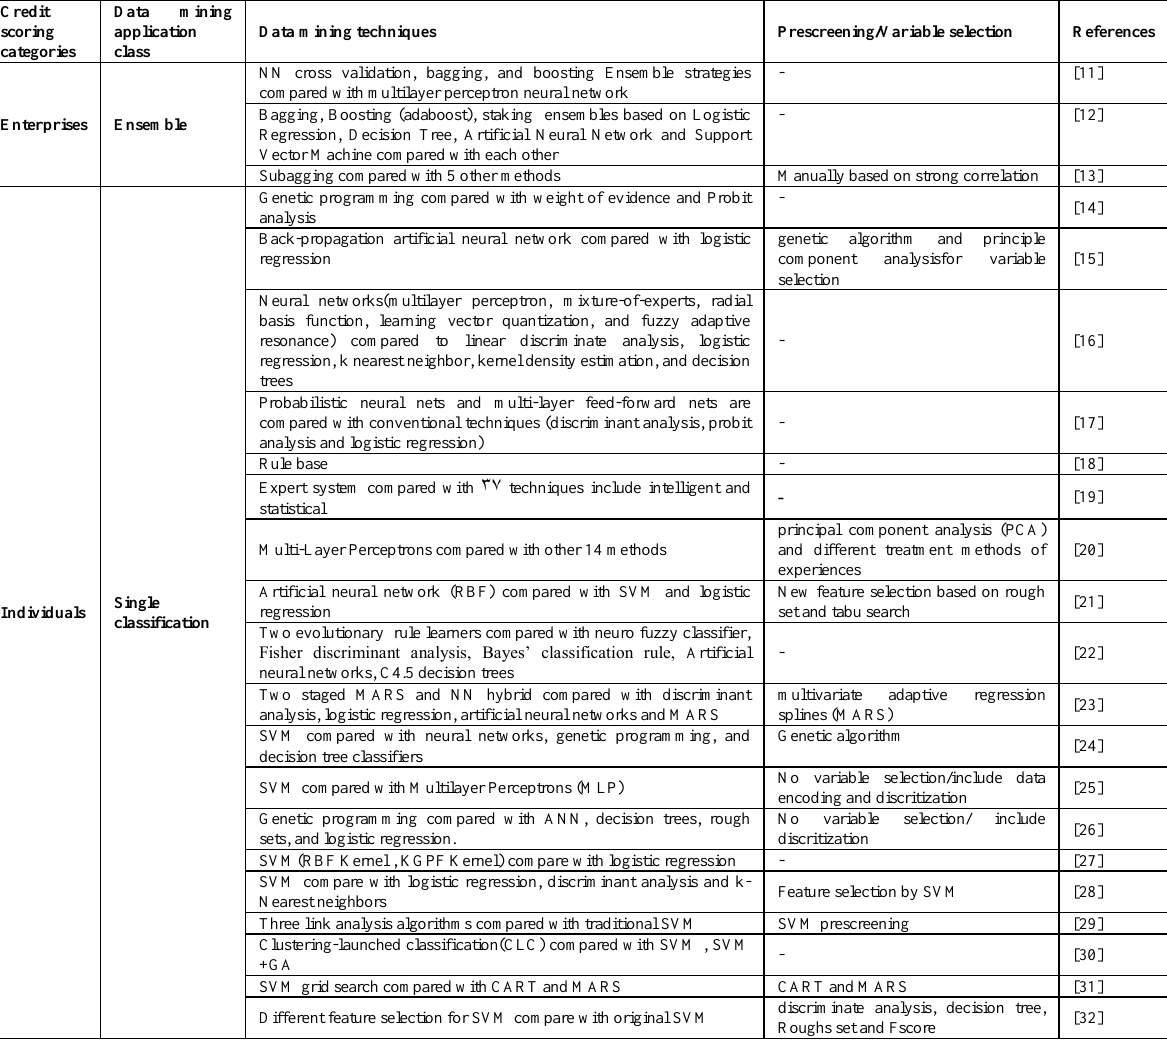
Table 1. Distribution of articles according to the proposed classification